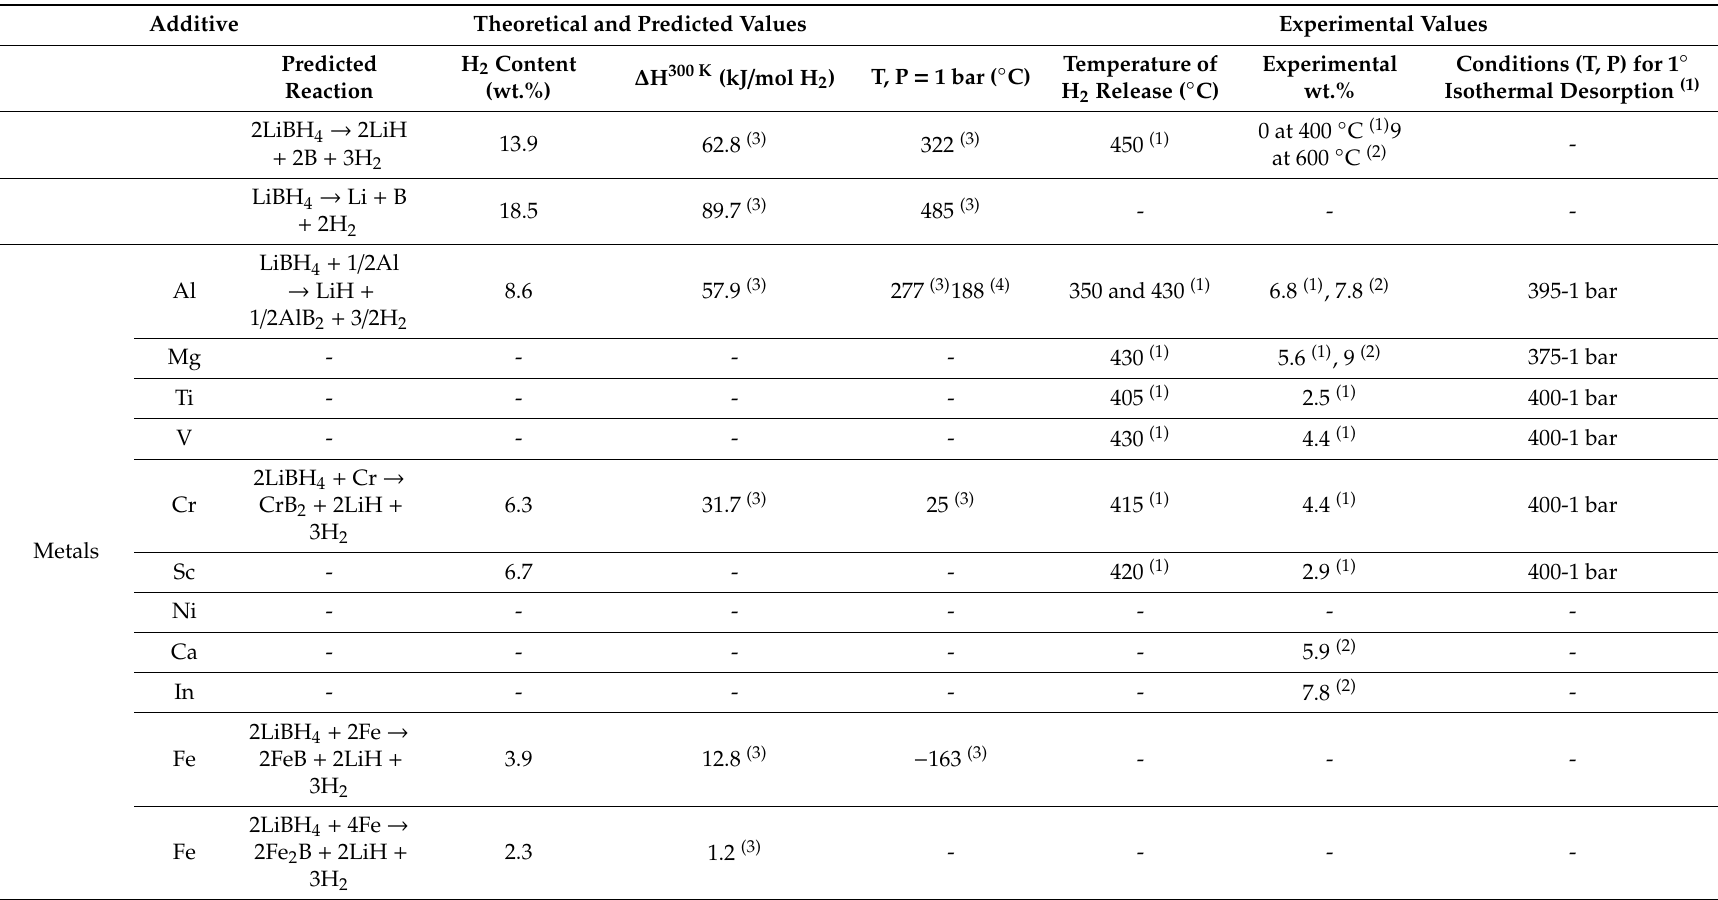
Table 3. Calculated and experimental hydrogen storage properties of LiBH 4 -based